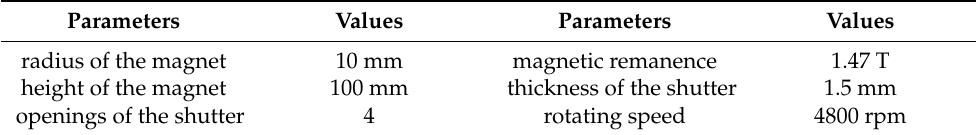
Table 1. The parameters of the